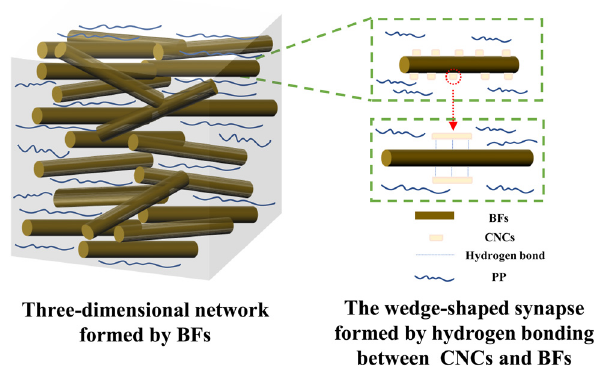
Figure 7: Mechanism diagram of the synergistic enhancement of polypropylene by CNC and basalt fi